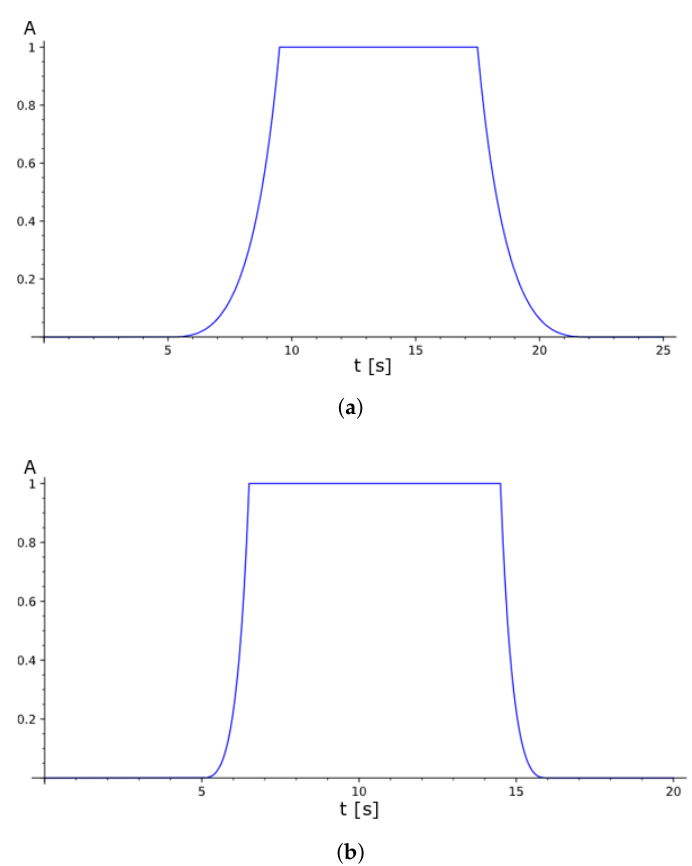
= 4.5 s; ( b ) ∆ t = 1.5 2 1